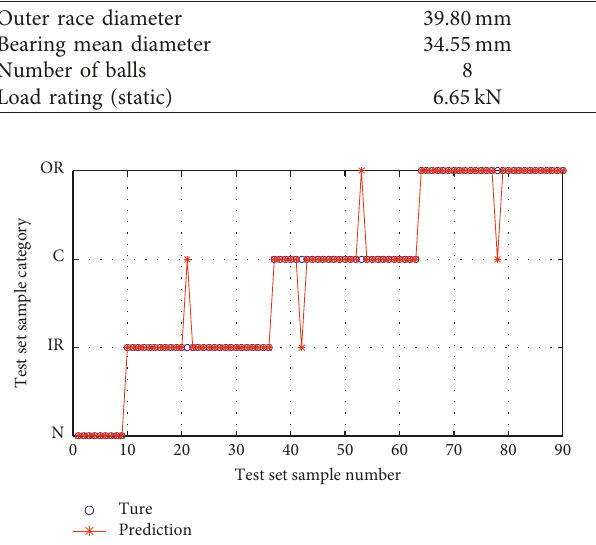
Figure 17: Fault diagnosis based on the XJTU-SY bearing data set: results of NKH-KELM with classification accuracy �